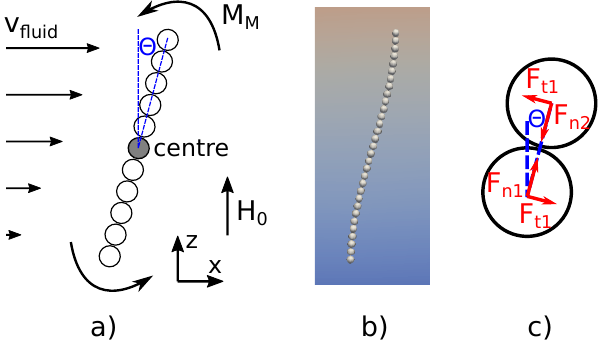
Figure 1. ( a ) Linear particle chain model in a fluid flow with homogeneous strain rate ˙ γ f . ( b ) Simulation result of the same problem with our OpenFOAM based solver. ( c ) Magnetic force between two neighboring particles on the bent